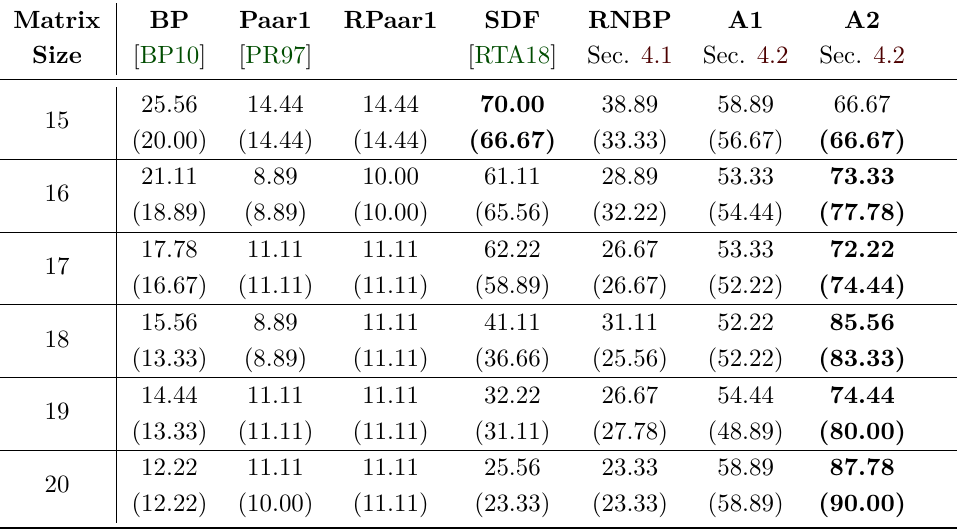
Table 4: Percentage of best circuits (XOR counts) produced by various algorithms for various square matrix sizes. The brackets contain the percentage of the BLOY circuits. The best percentages for both ALOY and BLOY circuits are highlighted in bold Matrix BP Paar1